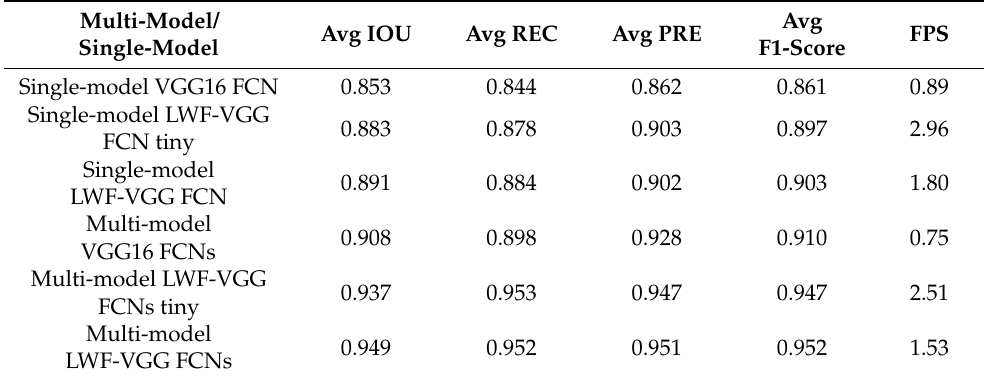
Table 5. Multi-model and single-model testing using the NTUT mixed dataset. Avg: average; IOU: intersection over union; REC: recall; PRE: precision; FPS: frame per